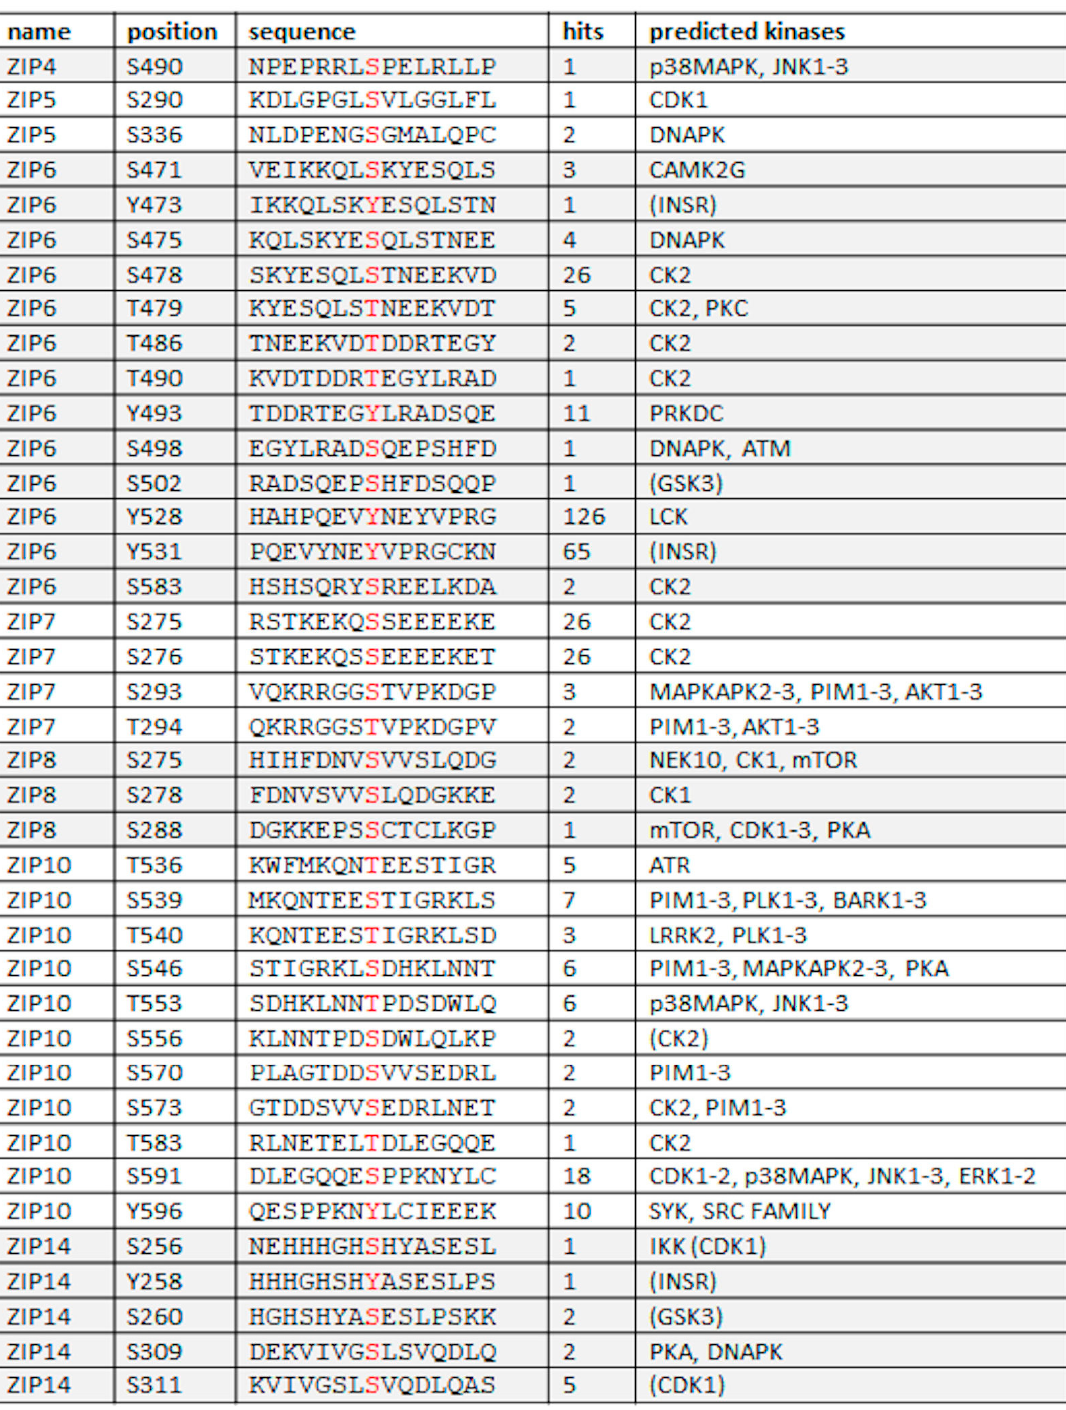
Figure 6. Predicted phosphorylation sites in the LIV-1 family of ZIP transporters. This table only includes the predicted sites on the cytoplasmic loop between TM3–4 and only those sites that were confirmed positive by mass spectrometry studies as detailed in the Phosphositeplus software [49] with occurrences listed in the hits column. Phosphorylated residues are shown in red. ZIP12 and ZIP13 are omitted as they did not have any predicted sites that met these criteria. Kinase predictions were taken from a number of prediction sites and those not reaching the cutoff in NetPhos [50] are shown in